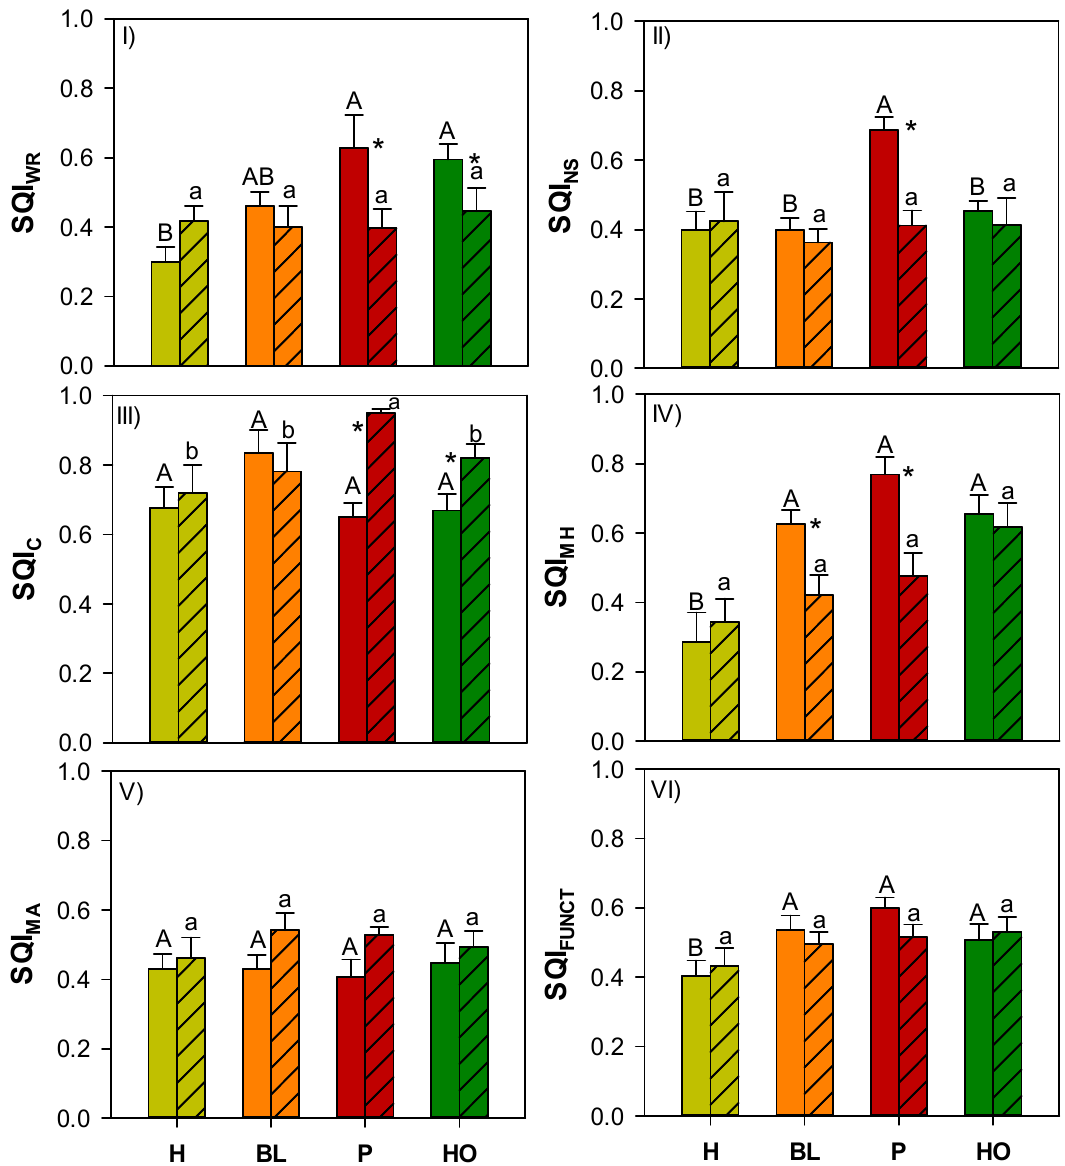
Figure 2. Mean values ( ± st. err.) of SQIs calculated for each function (water retention—SQI WR , nutrient supply—SQI NS , contamination—SQI C , microorganism habitat—SQI MH and microorganism activity—SQI MA ), and on the basis of all functions (SQI FUNCT ) calculated in unburnt (no pattern) and burnt (coarse pattern) soils samples under different vegetation cover type (herbs—H, light green; black locust—BL, orange; pine—P, red; holm oak—HO, dark green). Different capital and small letters indicate significant differences (at least, p < 0.05, Kruskal–Wallis test) in soil characteristics among vegetation cover types, respectively, at unburnt and burnt sites. (Kruskal–Wallis test). Asterisks indicate significant differences ( p < 0.05) between unburnt and burnt sites within the same vegetation cover type (Wilcoxon test).